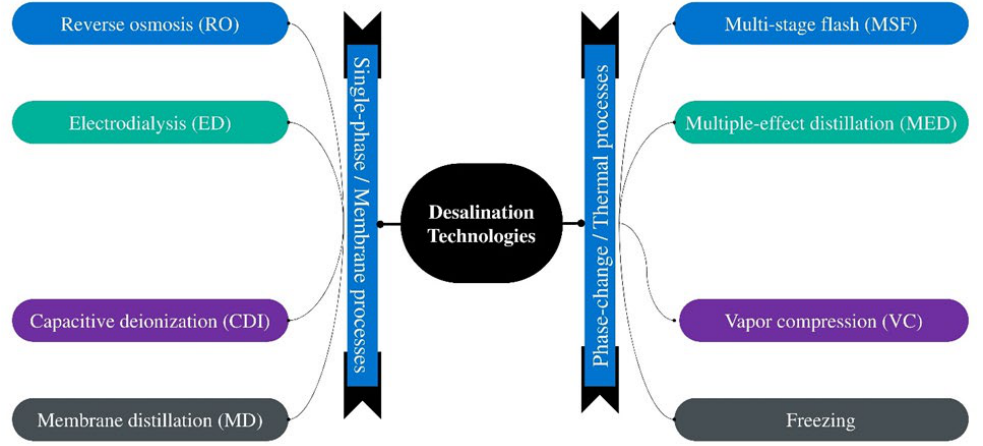
Figure 5. Different methods of water desalination.